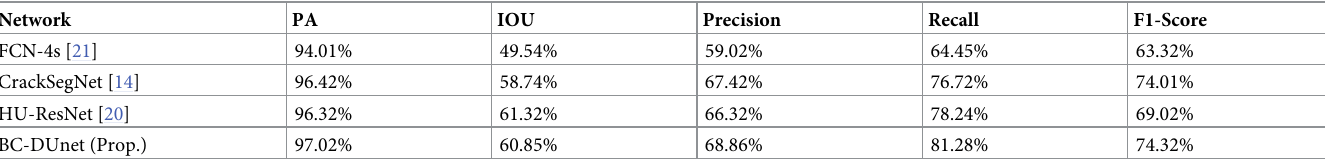
Table 4. Experimental performance comparison